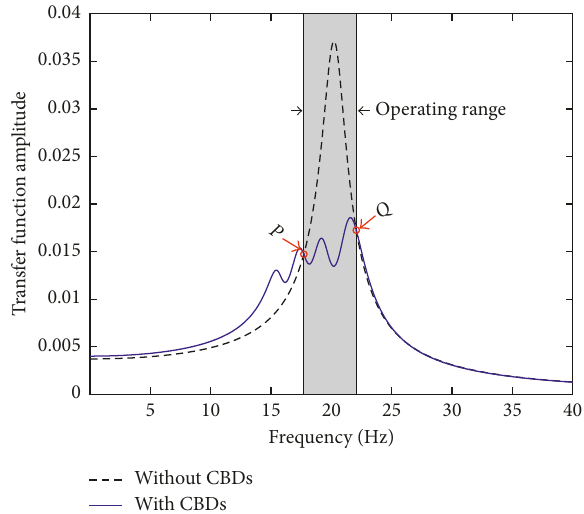
Figure 4: Transfer function of the structure with and without optimal